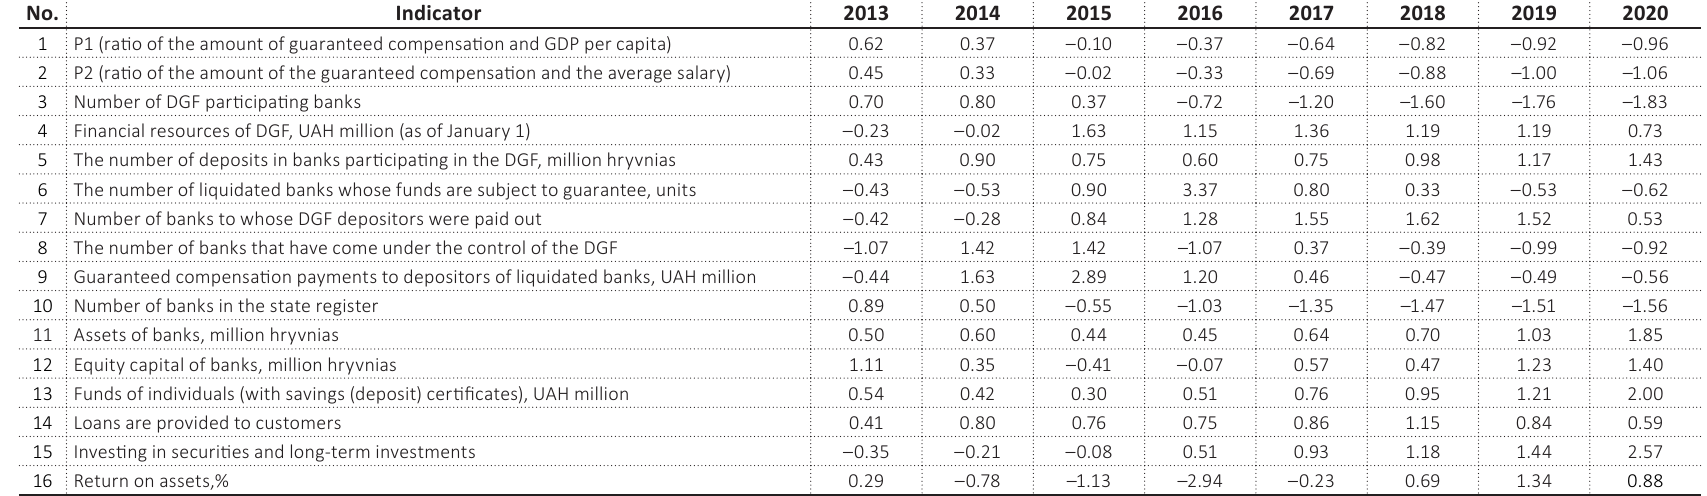
Table A4. Standardized values of deposit insurance indicators in Ukraine in